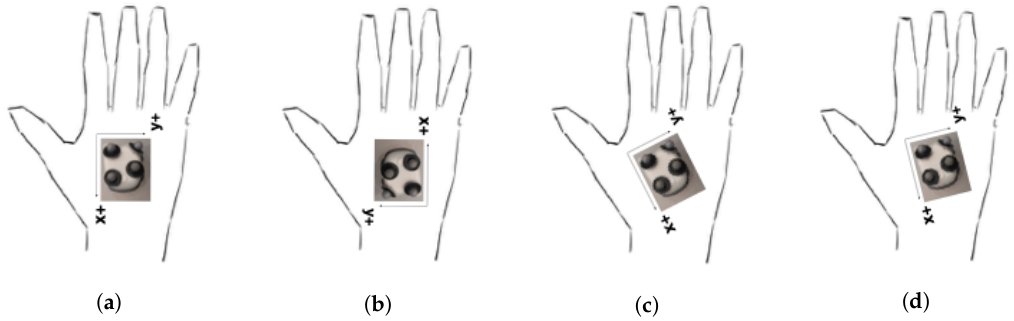
Figure 11. Different IMU positions used by the musicians to perform the musical excerpts. ( a ) Used by Musician 2 in excerpts 1 and 2; ( b ) Used by Musician 1 in excerpts 1 and 2; ( c ) Used by Musician 1 in excerpt 3; ( d ) Used by Musician 2 in excerpt